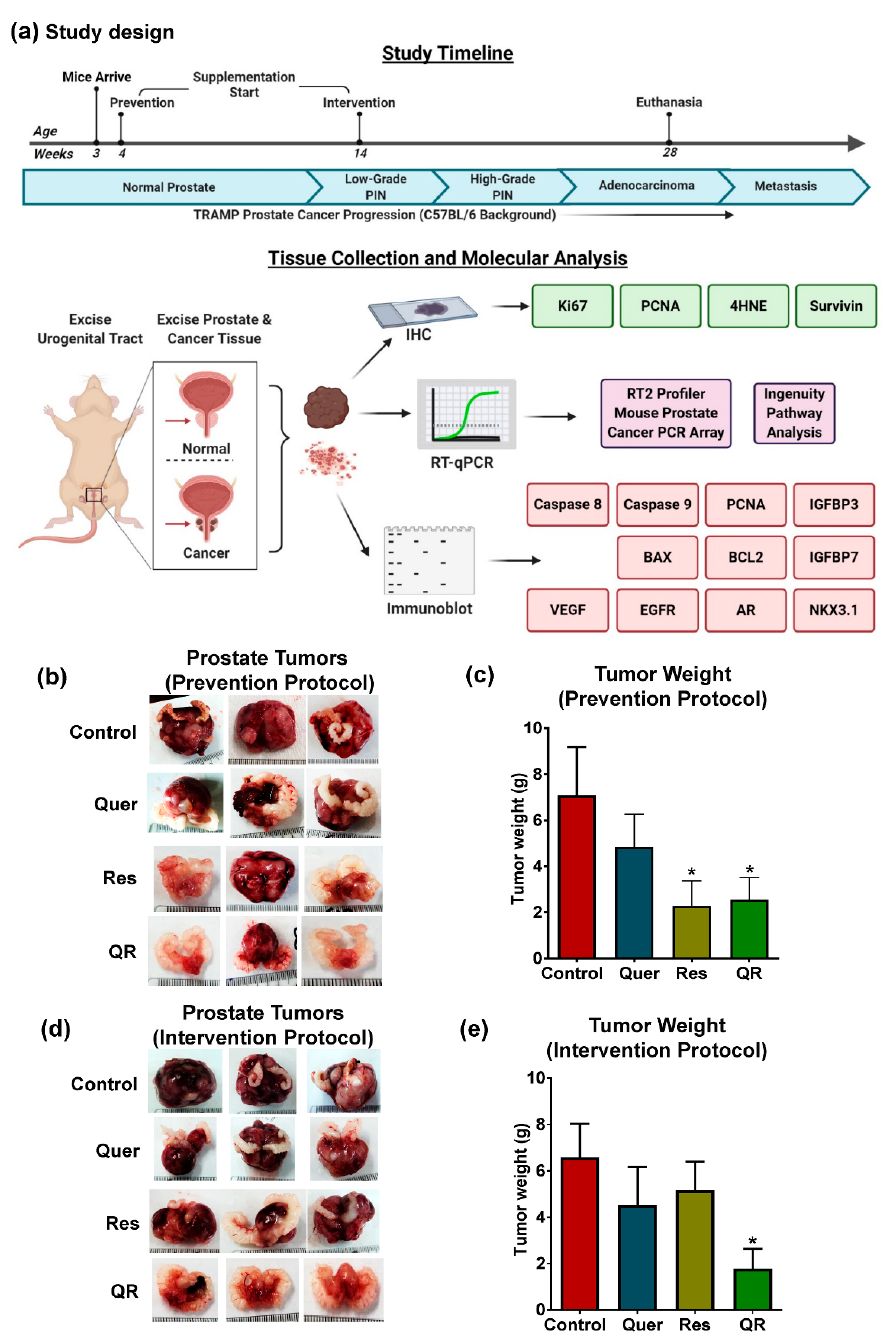
Figure 1. Dietary supplementation of grape antioxidants quercetin and resveratrol inhibit tumor development and progression in Transgenic Adenocarcinoma of Mouse Prostate (TRAMP) model. ( a ) Preclinical study design and the timeline for prevention and intervention settings in TRAMP mice. ( b ) Representative images of tumors with scale bar showing the size of tumors at the termination of study in prevention setting. ( c ) Graphical representation of tumor wet weight data in prevention setting. ( d ) Representative images of tumors with scale bars in the intervention setting. ( e ) Tumor wet weight data in the intervention setting. The tumor data are represented as mean ± SEM of 12 animals per group. GraphPad Prism 5 Software was used to perform statistical analyses on tumor data using one-way analysis of variance (ANOVA) followed by uncorrected Fisher’s Least Significant Difference (LSD) test (* p <0.05).